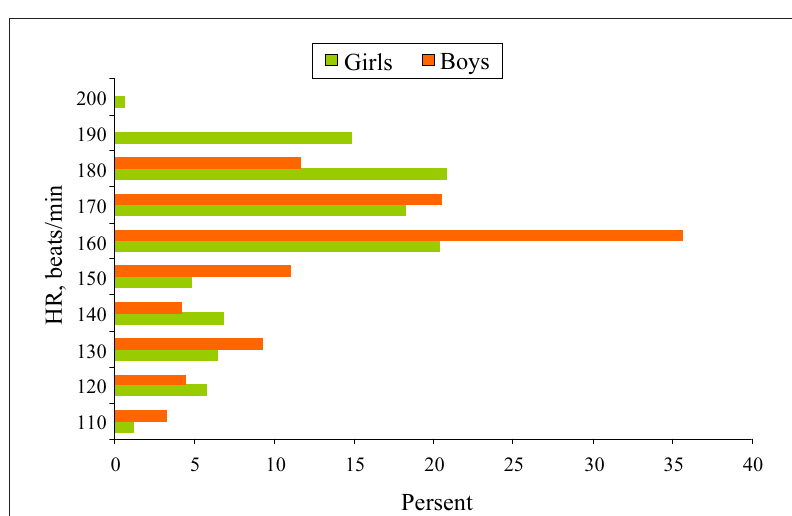
Figure 6. Percentage distribution of juvenile sports dancers’ heart rate